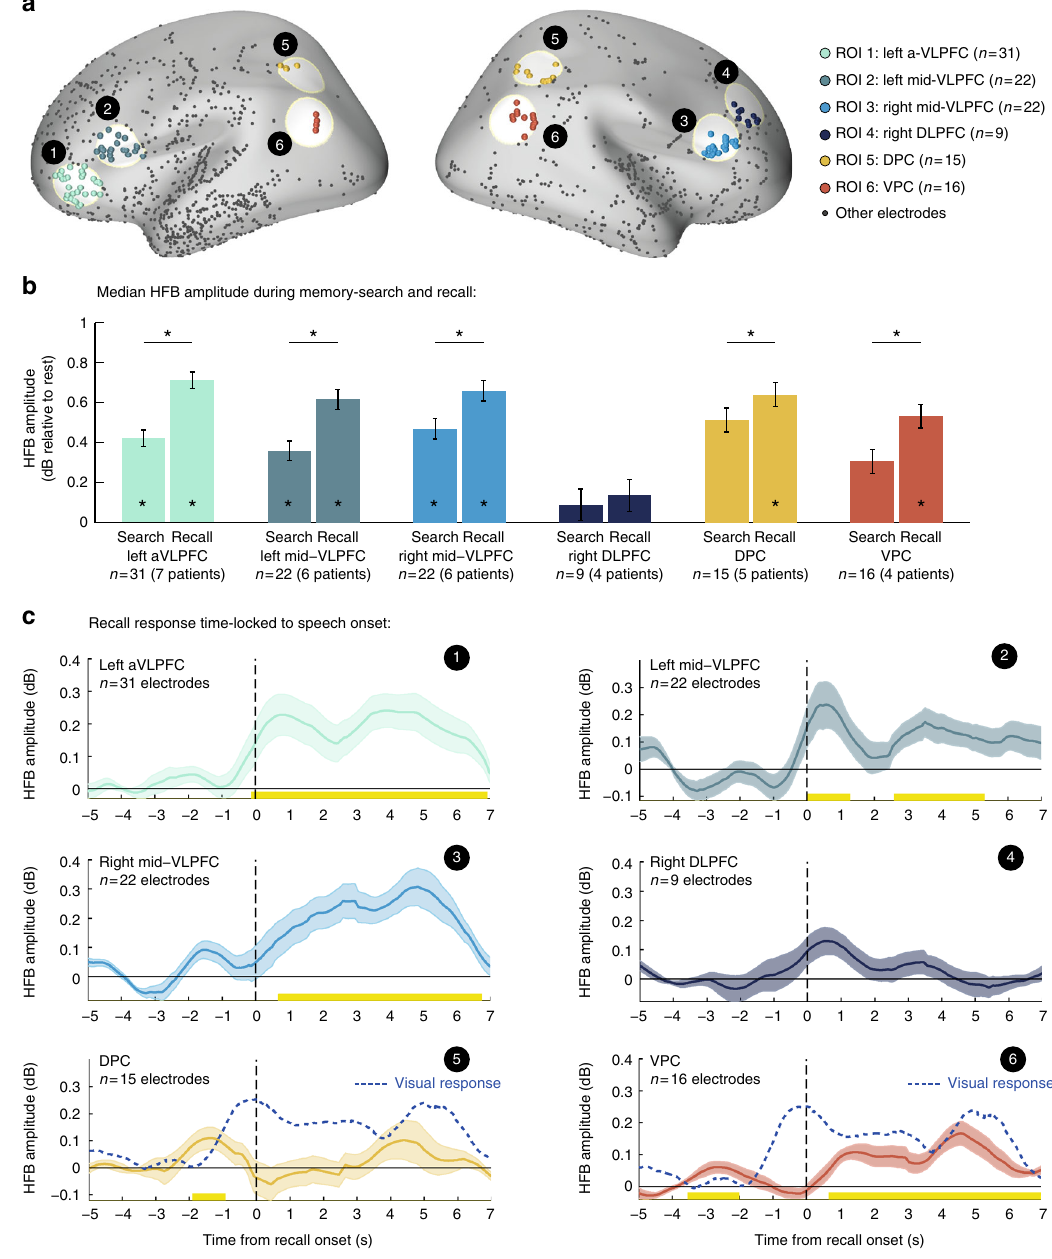
Fig. 9 Prefrontal and parietal ROI analysis. a Anatomical location of each region of interest (ROI). b Mean median HFB amplitude during overt recollection periods and during inter-recall intervals (i.e., presumed memory search periods). Signi fi cant differences were found between search and recall in all regions of interest except for the DLPFC (* p < 0.05, FDR corrected). Error bars represent SEM of within electrode differences estimated by the mixed-effects model. c HFB response in each region time-locked to the onset of individual recall events. Note the activation latency of prefrontal regions, which followed the response of category selective electrodes (Fig. 5). Parietal regions on the other hand showed a small transient response anticipating the differential activation of category-selective visual electrodes (dashed blue line). Abbreviations: aVLPFC — anterior ventrolateral prefrontal cortex (~BA10/47); mid-VLPFC — mid-posterior ventrolateral prefrontal cortex (~BA45); DLPFC — dorsolateral prefrontal cortex (~BA8/9); DPC — dorsal parietal cortex (~BA39/7); VPC — ventral parietal cortex